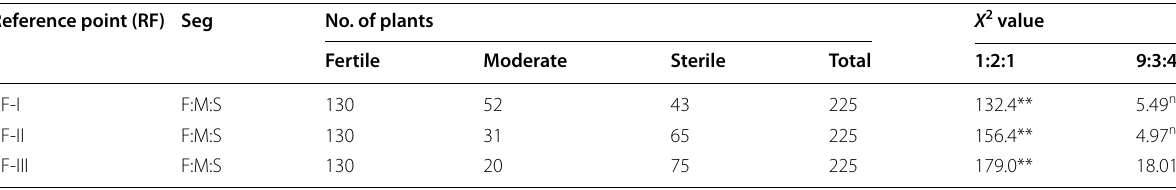
Seg.: segregation of spikelet fertile classified into three classes: F (Fertile), S (Sterile), and M (Moderate fertile) according to reference point (RP) distinguish fertility from sterility. RF-I (F: M: S over 85%: 85–45%: less than 45%), RF-II (F: M: S =